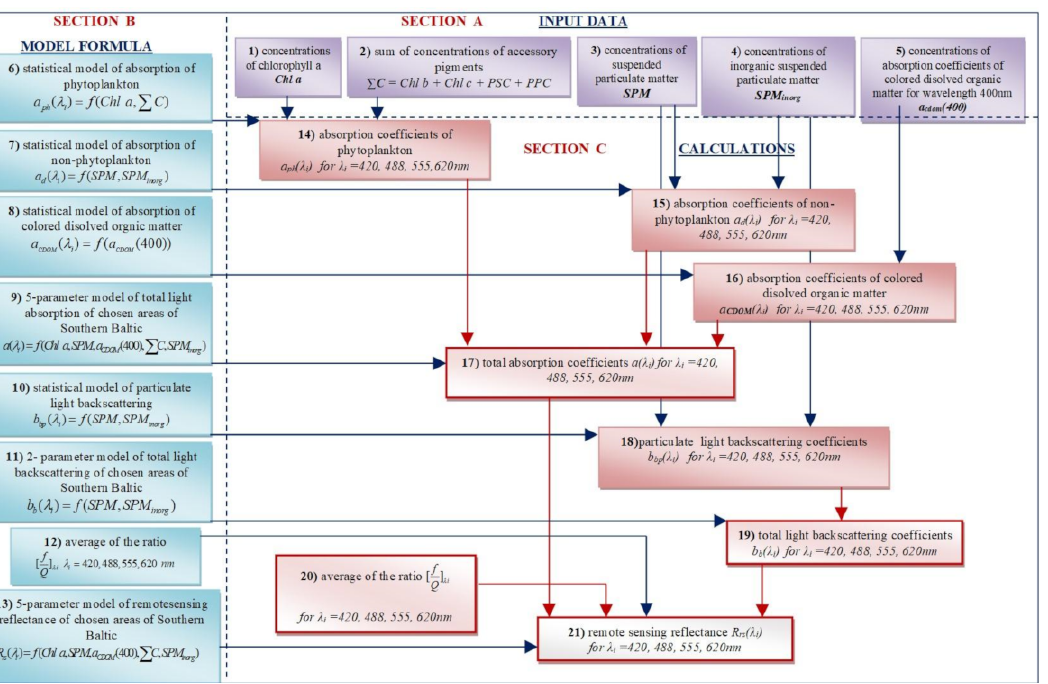
Figure 1. Block diagram of the five-parameter model of R rs in the selected areas of the southern Baltic for four wavelengths ( λ i = 420 nm, 488 nm, 555 nm, and 620